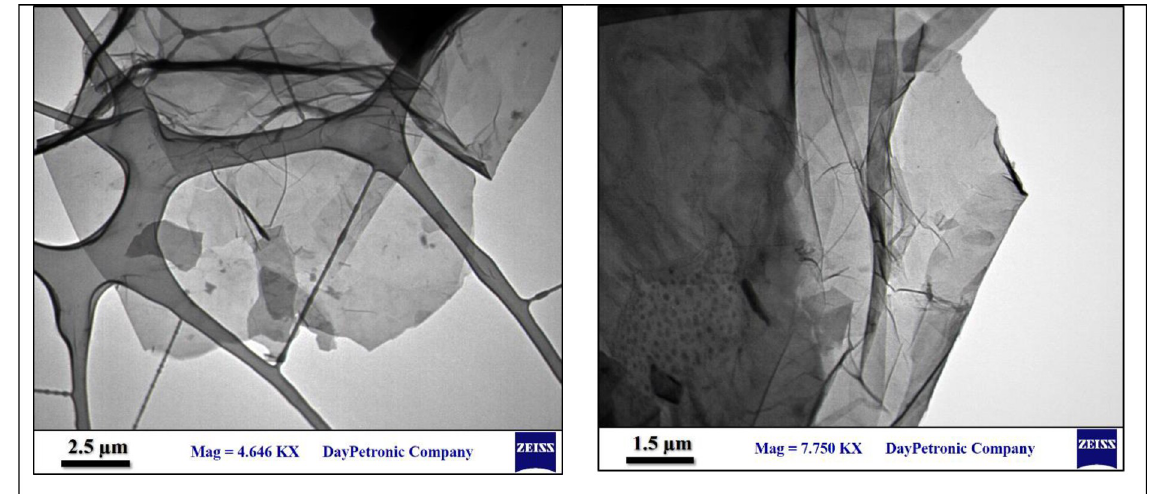
Fig 4. TEM images with different magnifications of nano-bio graphene synthesized by thermo-chemical reduction method.